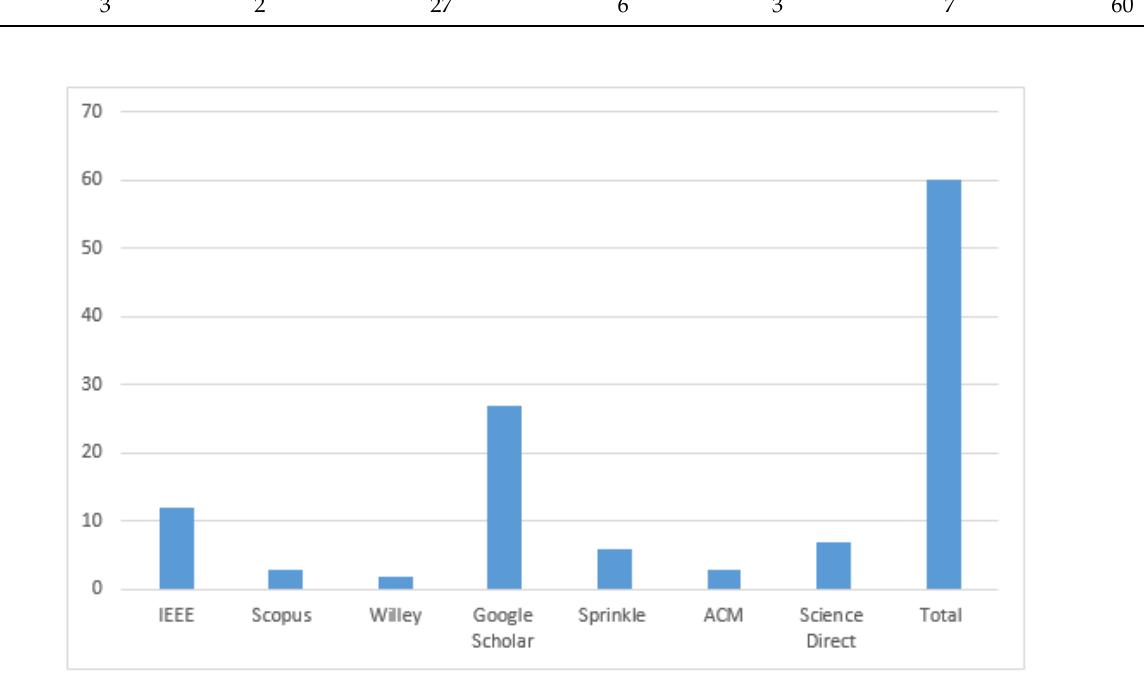
Figure 4. Final paper selection.